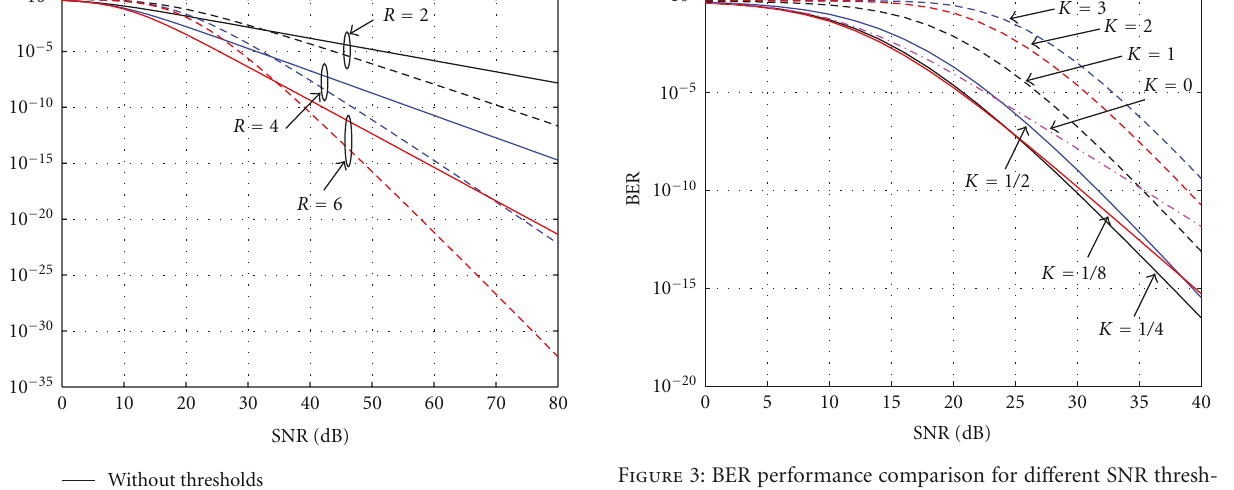
Figure 3: BER performance comparison for di ff erent SNR thresh- olds when R = 8: without the direct link.